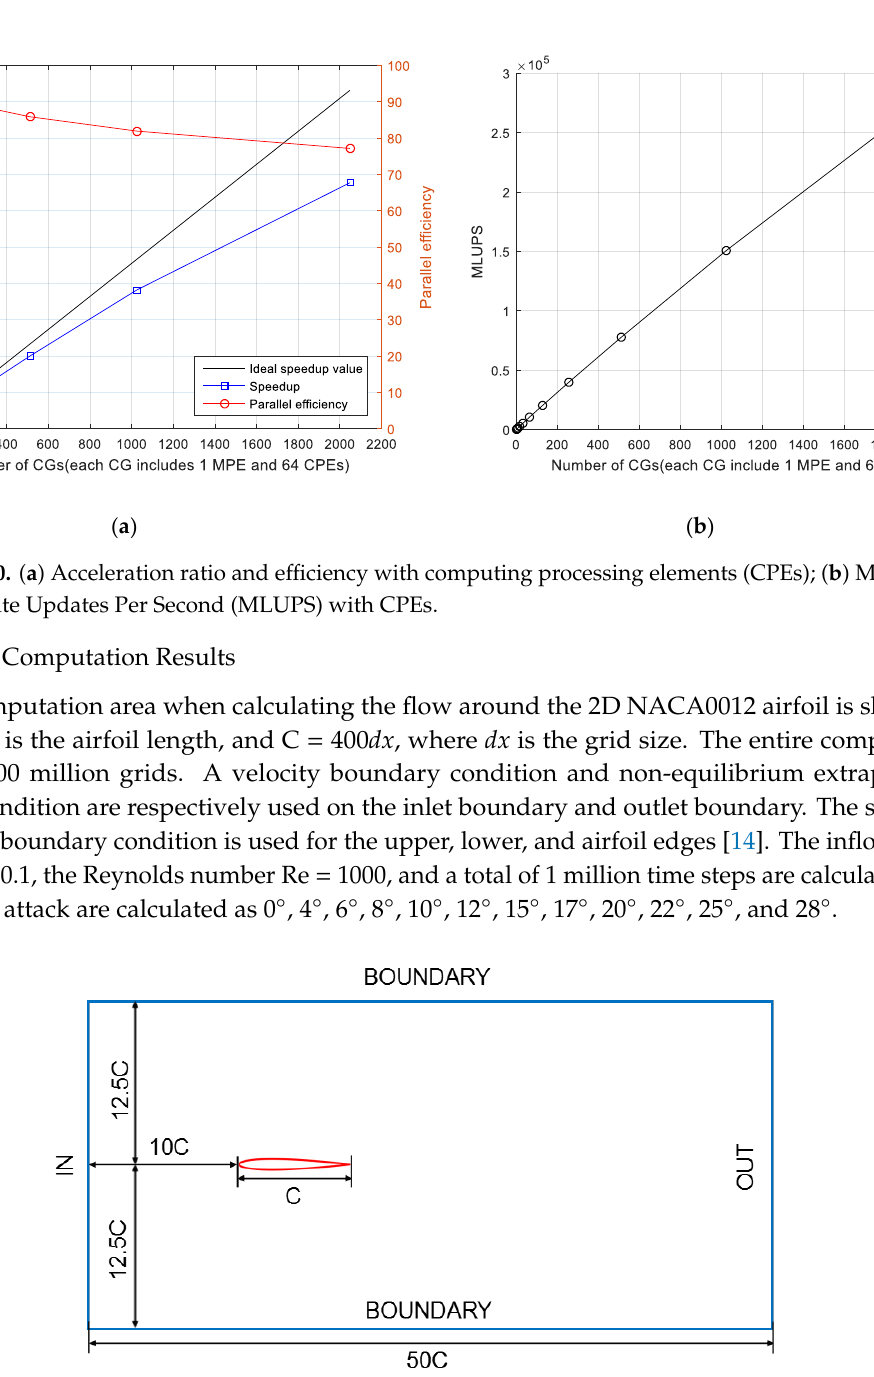
Figure 11. Computation area. The left side is the inflow and the right side is the outflow.